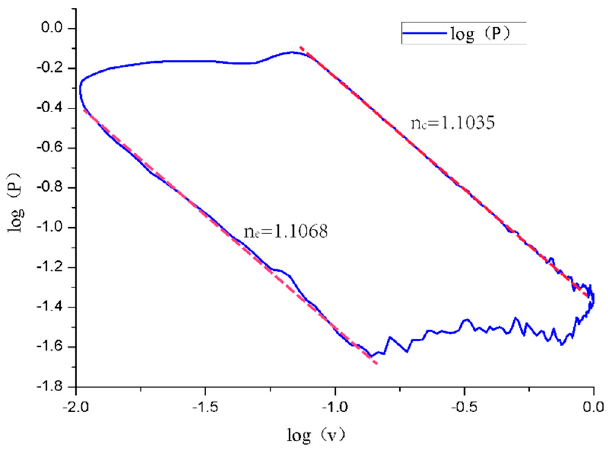
Figure 9. Logarithmic p-V diagram.